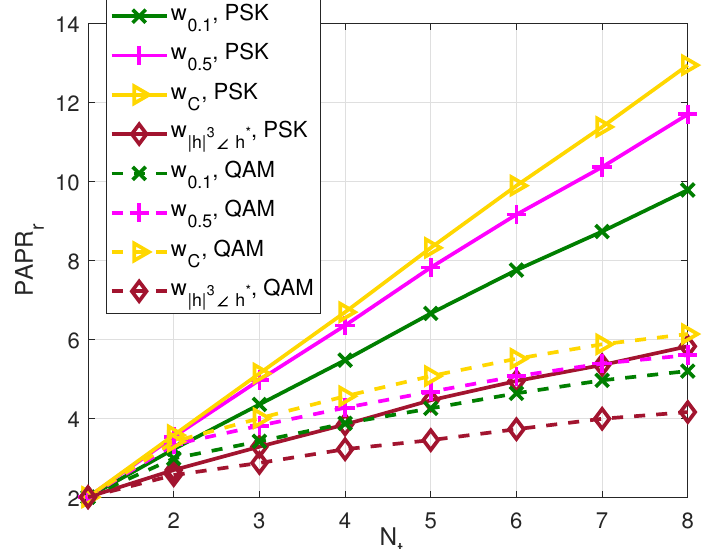
Figure 14. PAPR of received signals using multisine PSK modulation and QAM modulation- to explain symbol on y-axis better. with increasing N t using the proposed pre-equalizers of a multisine SWIPT